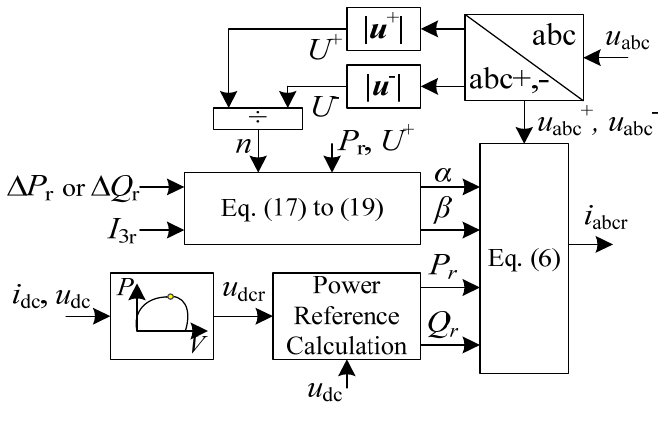
Figure 5. Online adjustment of coefficients α and β for harmonic currents suppression.